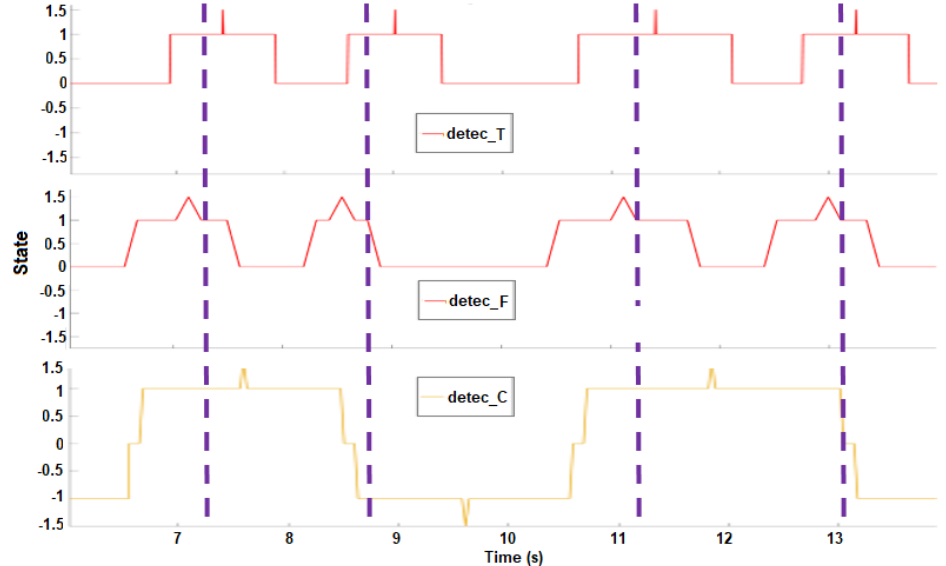
Figure 10. Final decision-making for breathing activities assessment. ( Top ): results from temporal detection. ( Middle ): results from frequency detection. ( Bottom ): results from cardiac (PDR) detection. The final detected events are marked in purple dashed